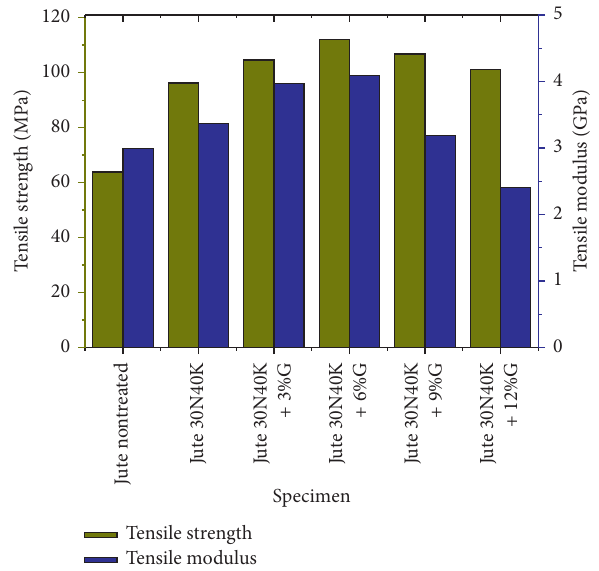
Figure 2: Tensile strength of UJE polymer composites.